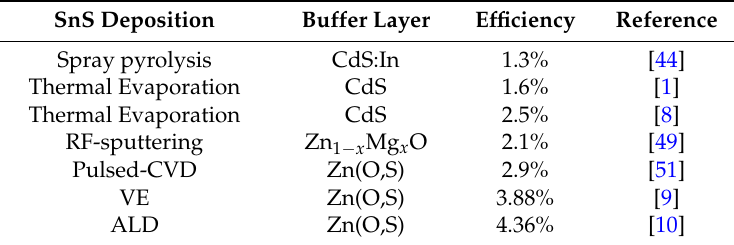
Table 1. Summary of main results on SnS solar